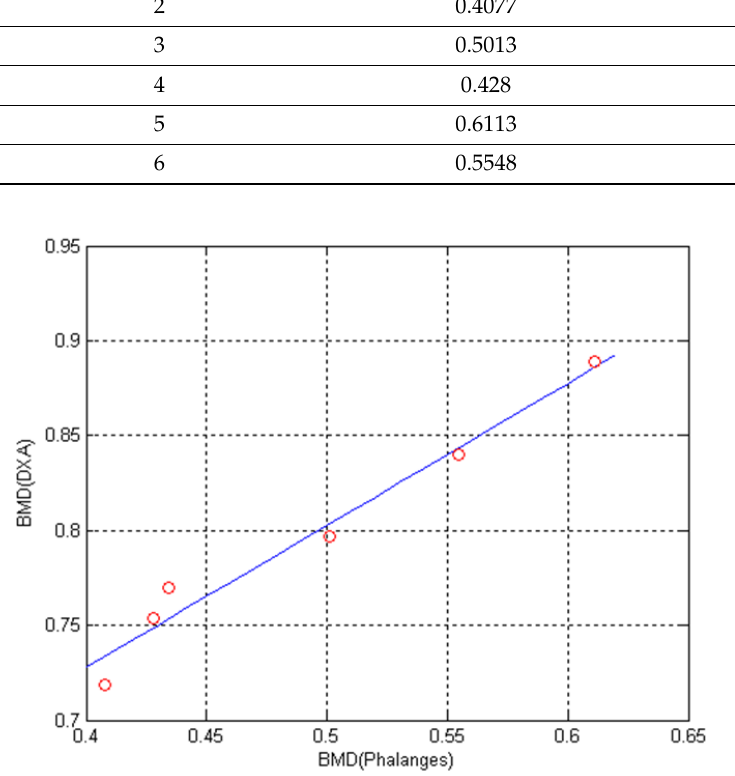
Figure 13. Graph between BMD computed from the proposed bone mineral density system against that measured by commercial bone mineral density system (R 2 = 0.969) Equation of fitting line y = 0.4285 + 0.7482x.